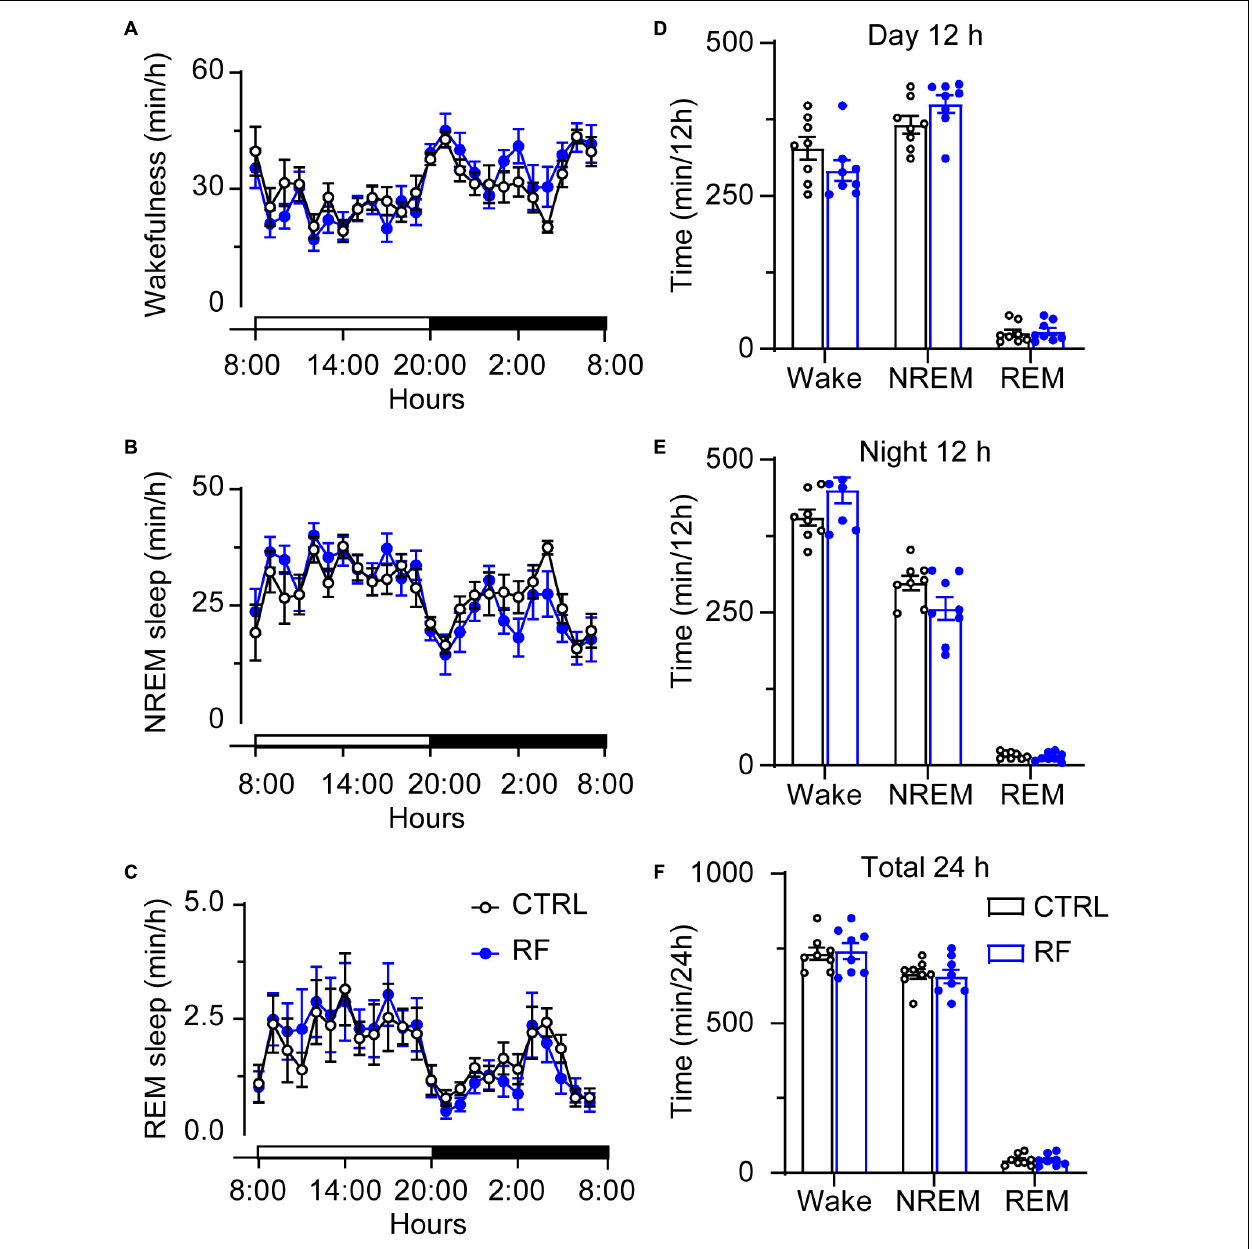
FIGURE 3 | Time spent in sleep-wake stages under baseline conditions of the mice in the RF and CTRL groups. Time spent in wakefulness (A) , NREM sleep (B) , and REM sleep (C) over a 24-h period. Cumulative time of wakefulness, NREM sleep, and REM sleep during the light period (D) , dark period (E) , and 24-h period (F) . Open and closed bars above the x -axis indicate light and dark periods, respectively. n = 6, CTRL, control; RF, restricted